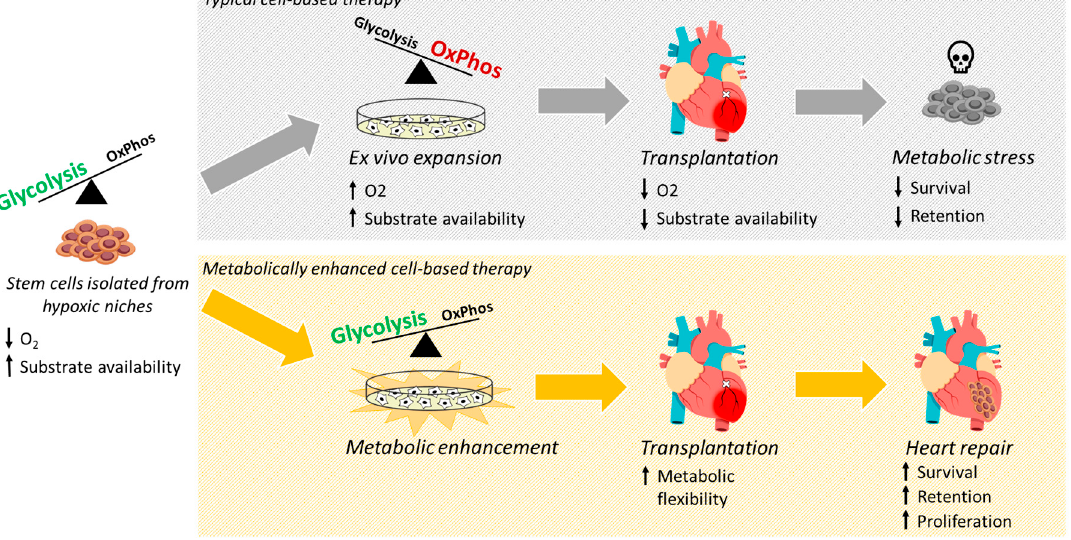
Figure 3. Cell-based therapies typically rely on isolating highly glycolytic stem cells from hypoxic niches followed by ex vivo expansion under high oxygen and glucose levels, which shifts energy generation towards a more oxidative metabolism. Upon transplantation, however, donated stem cells are exposed to an ischemic cardiac milieu characterized by an intense deprivation in oxygen and glucose essential for mitochondrial activity. This rough transition from in vitro to in vivo leads the cells to experience a metabolic stress driving transplanted cells towards apoptosis. Thus, the enhancement of stem cell metabolism holds a great promise towards promoting metabolic flexibility and improving cell survival and therapeutic efficacy.